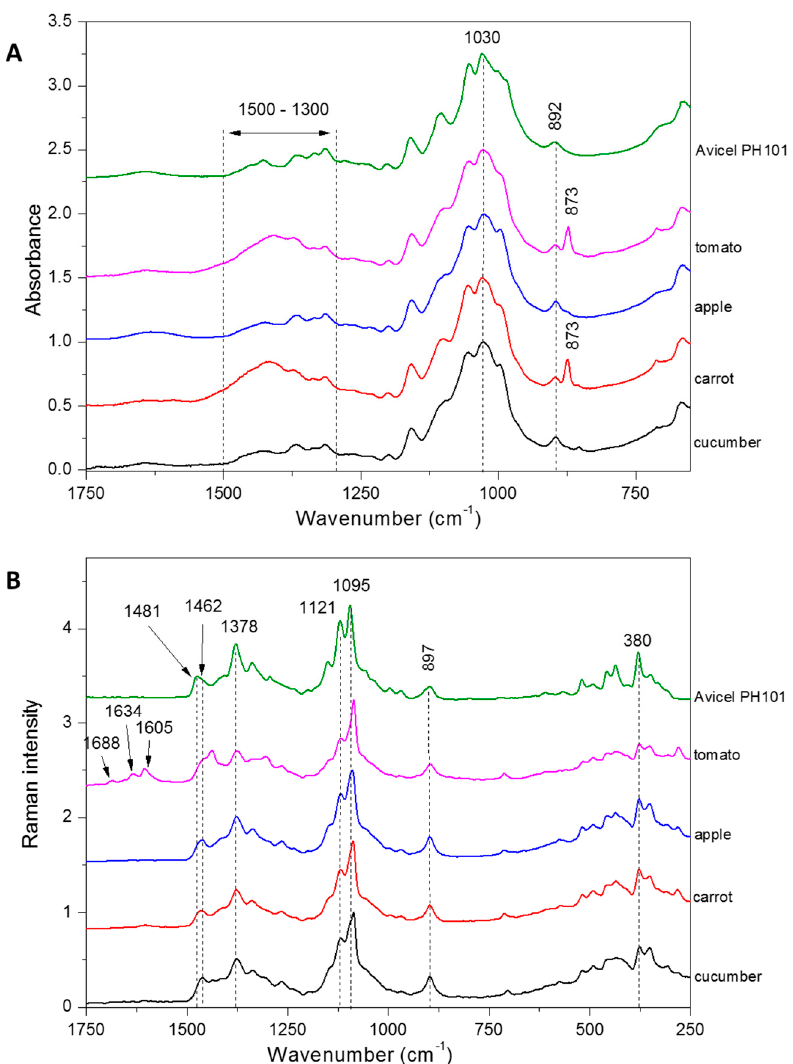
Figure 5. FTIR ( A ) and Raman ( B ) spectra of cellulose isolated from tomato, apple, carrot, and cucumber pomaces. The Avicel PH101 is presented here as an example of pure microcrystalline cellulose with well-defined structure. FT IR spectra are presented in the range of 1750–650 cm − 1 and Raman are presented in the range of 1750–650 cm − 1 . The most characteristic bands are highlighted on spectra with dashed line.